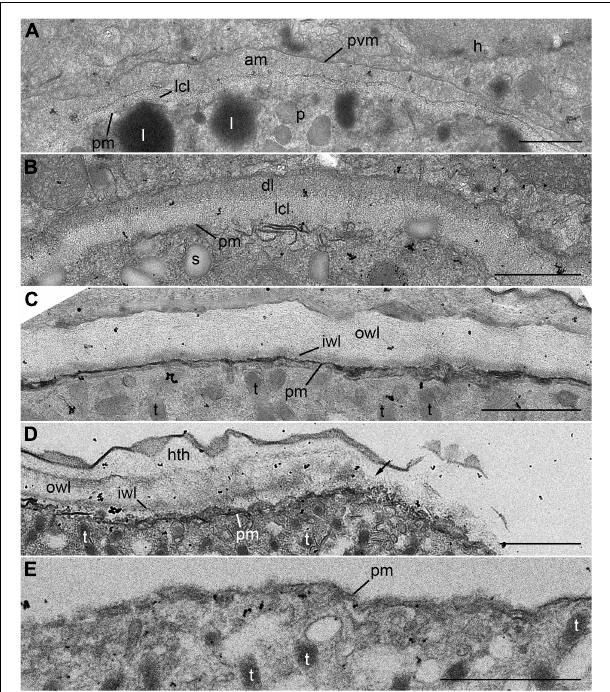
FIGURE 7 | Transmission electron microscope (TEM) images of the trophocyte wall (A–D) and cell membrane of sporocyte (E) during the development stages of Pararosarium dinoexitiosum . (A) The wall of the initial trophocyte (p) comprising a parasitophorous vacuole membrane (pvm), amorphous material (am), less compact layer (lcl), and plasma membrane (pm) within host cytoplasm (h). Lipid globules (l) are also shown. (B) The wall of the early trophocyte showing electron-dense layer (dl) and less compact layer (lcl) with plasma membrane (pm). Starch granule (s) are also shown. (C) The fully developed wall of the trophocyte consisting of two layers: an outer wall layer (owl), an inner wall layer (iwl) with plasma membrane (pm). Bipartite trichocysts (t) are also shown. (D) The bulge of trophocyte wall showing the accompanied breaking (arrow) of outer wall layer (owl) and inner wall layer (iwl). Host theca (hth), plasma membrane, and bipartite trichocysts (t) are also shown. (E) Sporocyte showing the plasma membrane (pm) and bipartite trichocysts (t). All scale bars = 1 µ